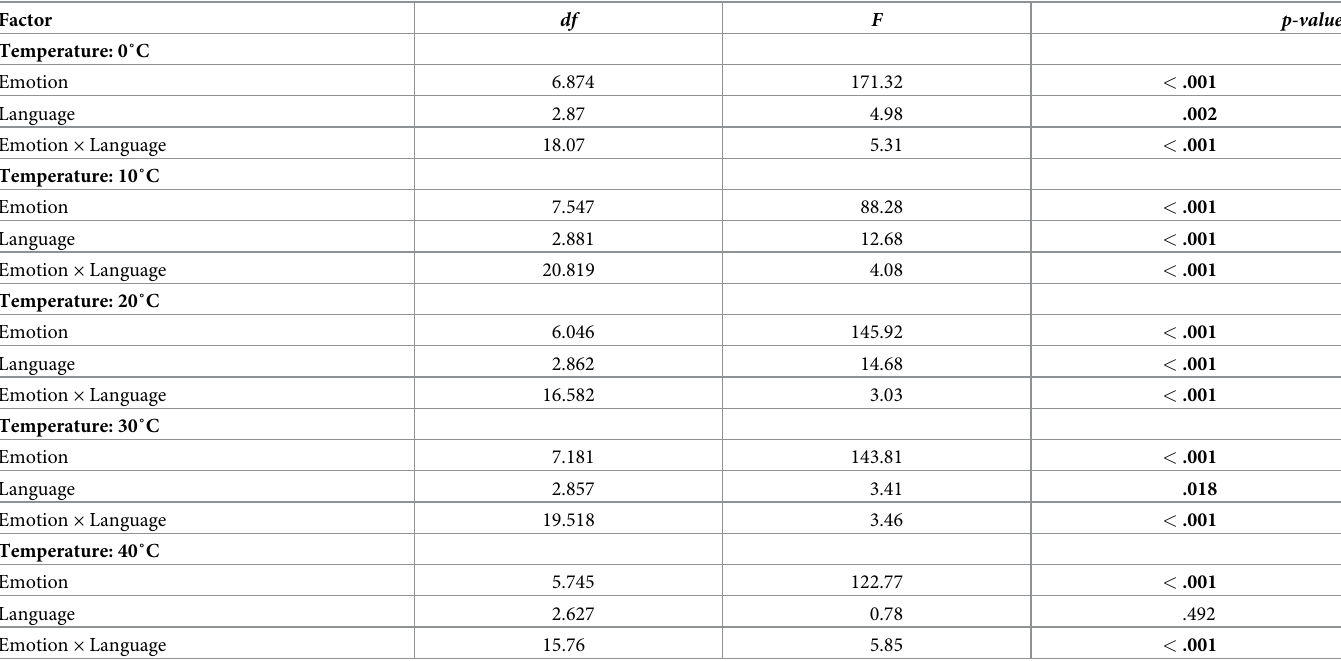
Table 2. ATS results in Experiment